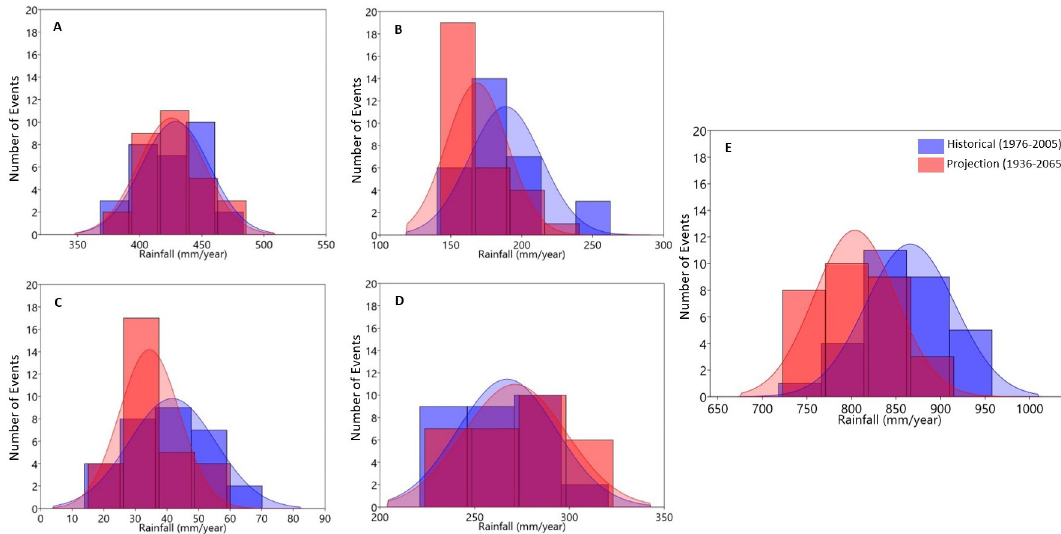
Fig 11. Probability distribution estimation of seasonal and annual total precipitation over the Olifants catchment (1976–2005 vs. 2026–2055) with relevant gamma distributions superimposed.